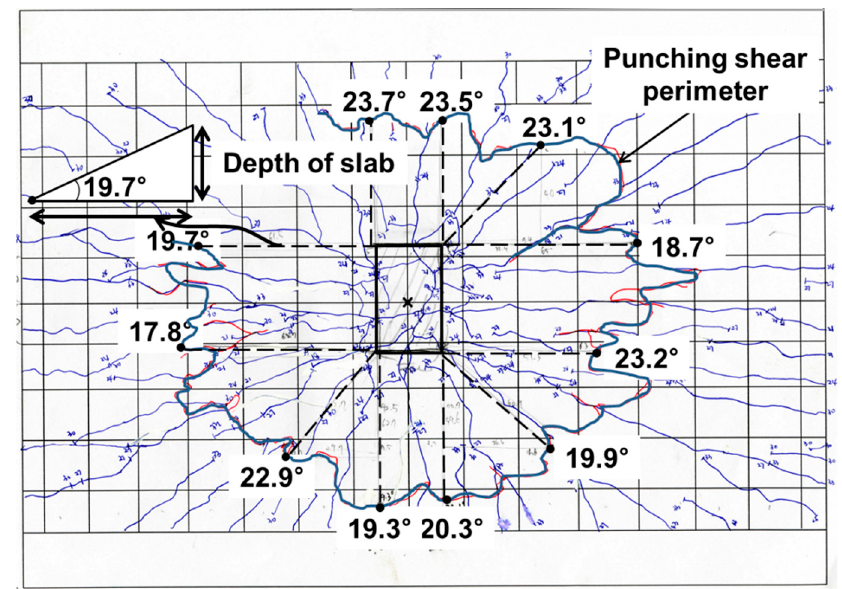
Figure 5. Illustration of the measured punching cone angle (STS). Table 3. Measured and average punching cone angle (unit in degrees).